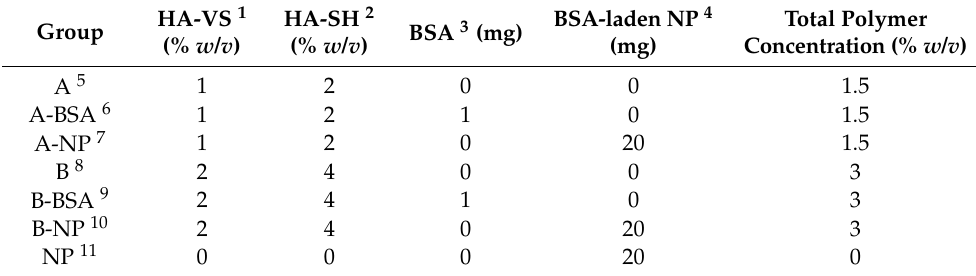
Table 1. Abbreviations of the tested groups and their